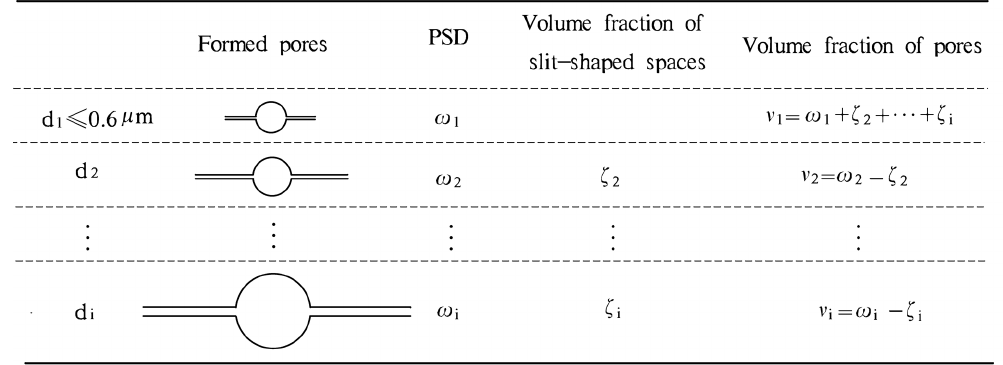
Figure 3. Schematic of the procedure used to calculate the pore volume fraction.